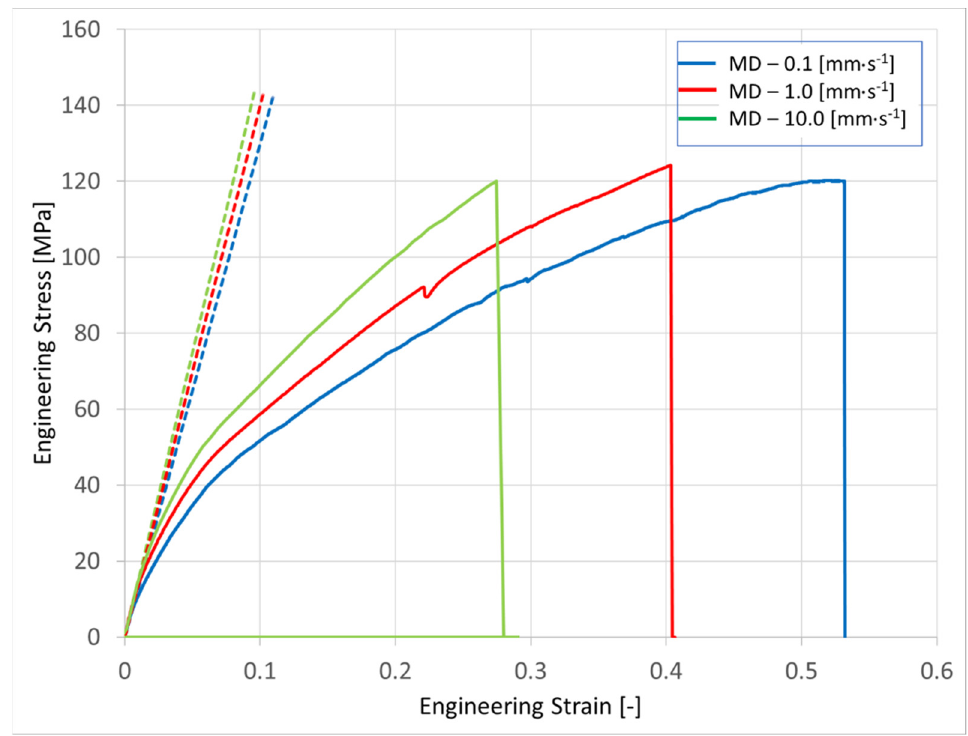
Figure 4. Tested engineering stress vs. strain curves in machine direction (MD = 0°), at three different velocities with the corresponding Young’s moduli (dashed lines).